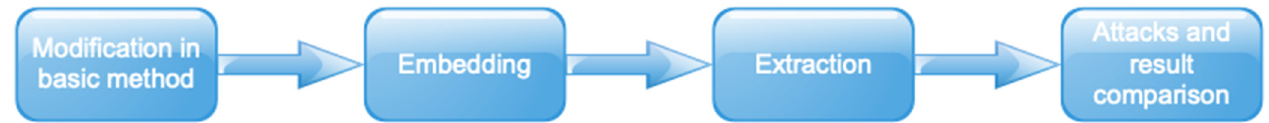
Figure 1. A basic model of a watermarking system.